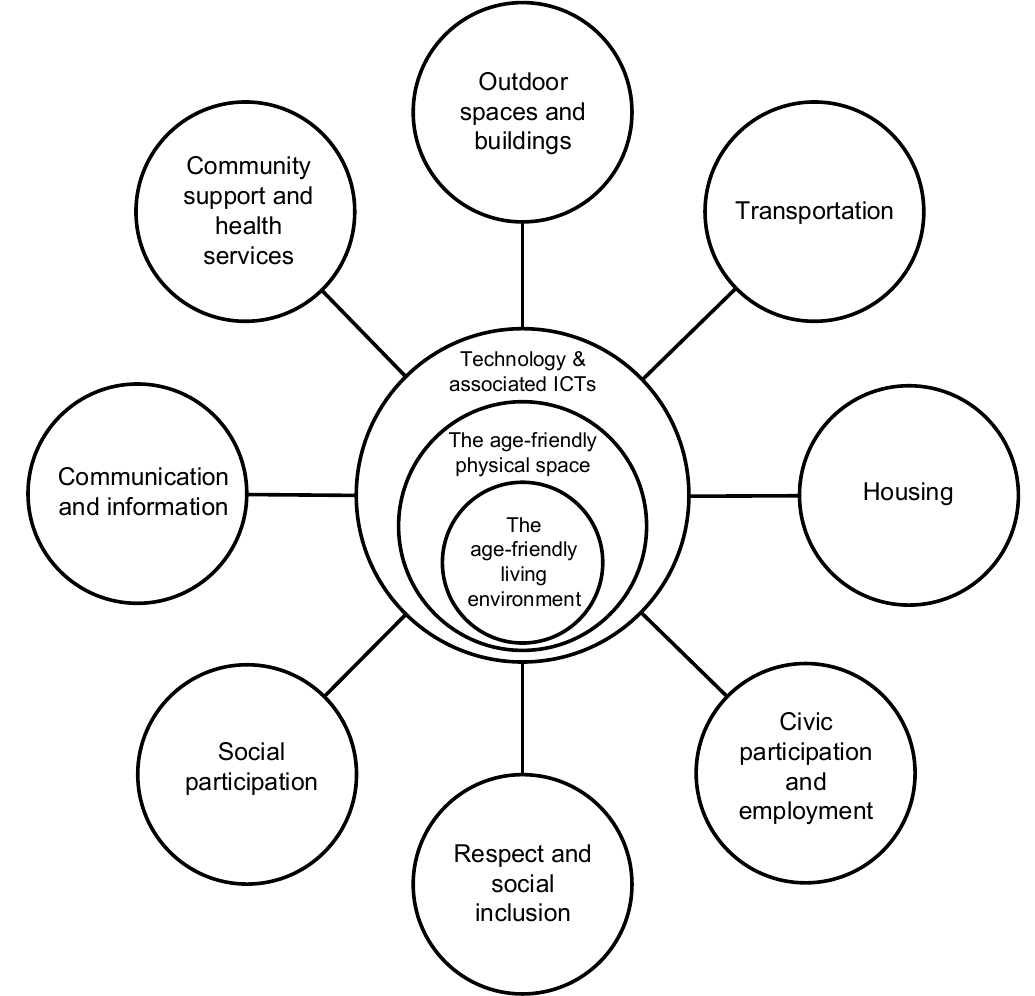
Figure 20. The proposed new smart age-friendly ecosystem framework.